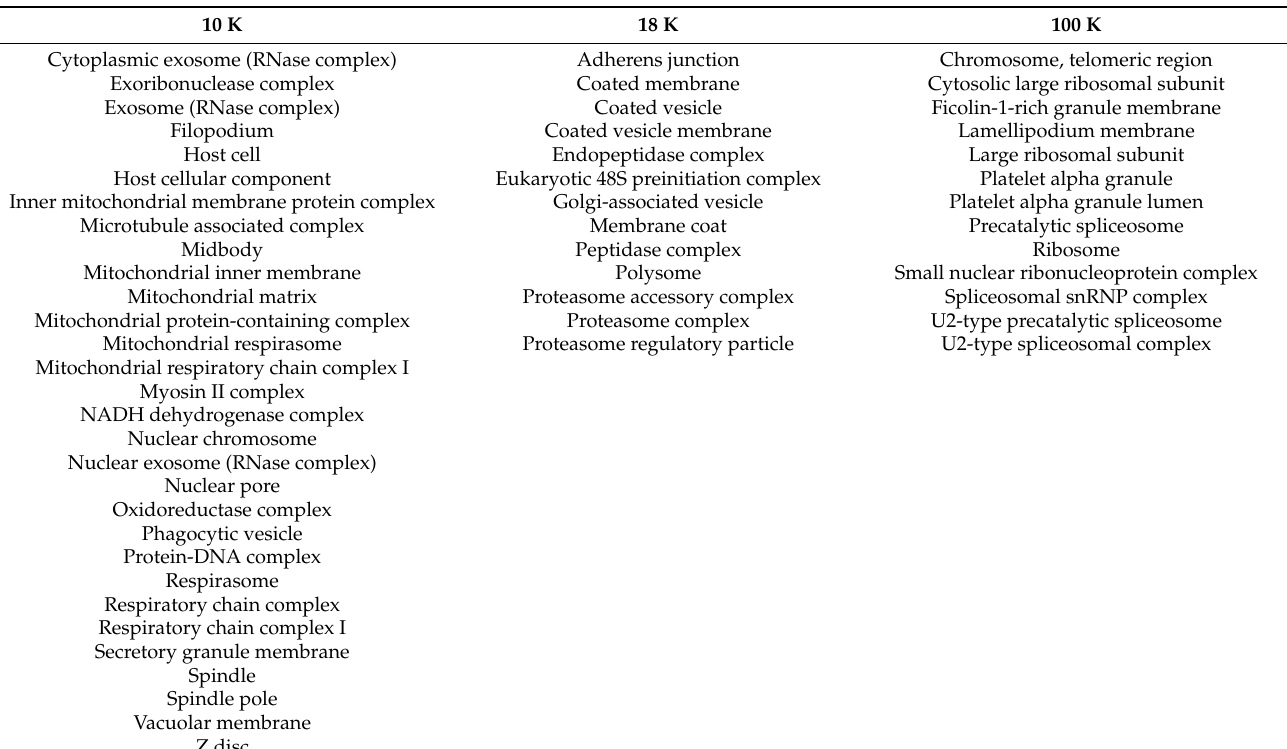
Table 5. Cellular components unique to each EV type derived from mesothelioma cell lines.